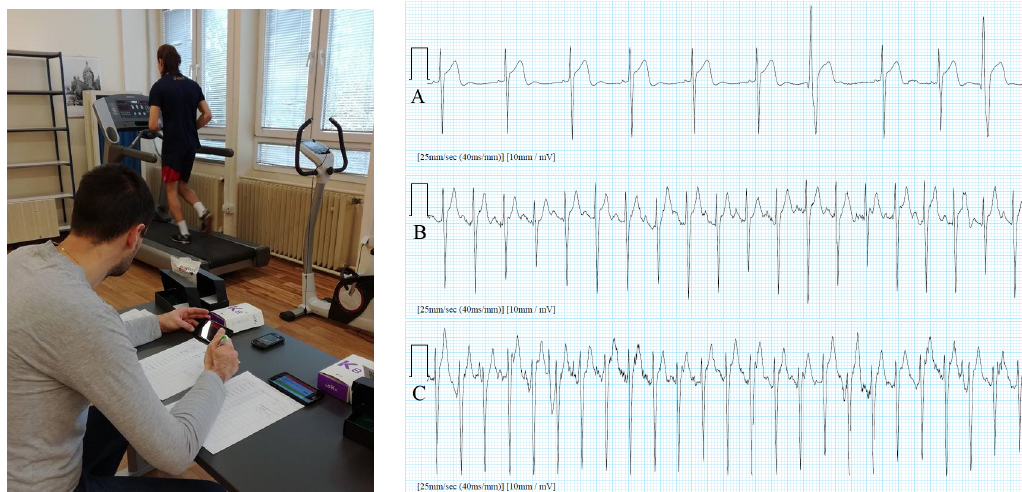
Figure 11. Running on a treadmill with the ECG body sensor fixed with self-adhesive tapes ( left ). Corresponding sections of ECG signals for different running speed ( right ): ( A ) initial resting (heart rate: 74 BPM), ( B ) medium activity (running speed: 14 km/h, heart rate: 140 BPM), and ( C ) maximum activity (running speed: 19 km/h, heart rate: 198 BPM).